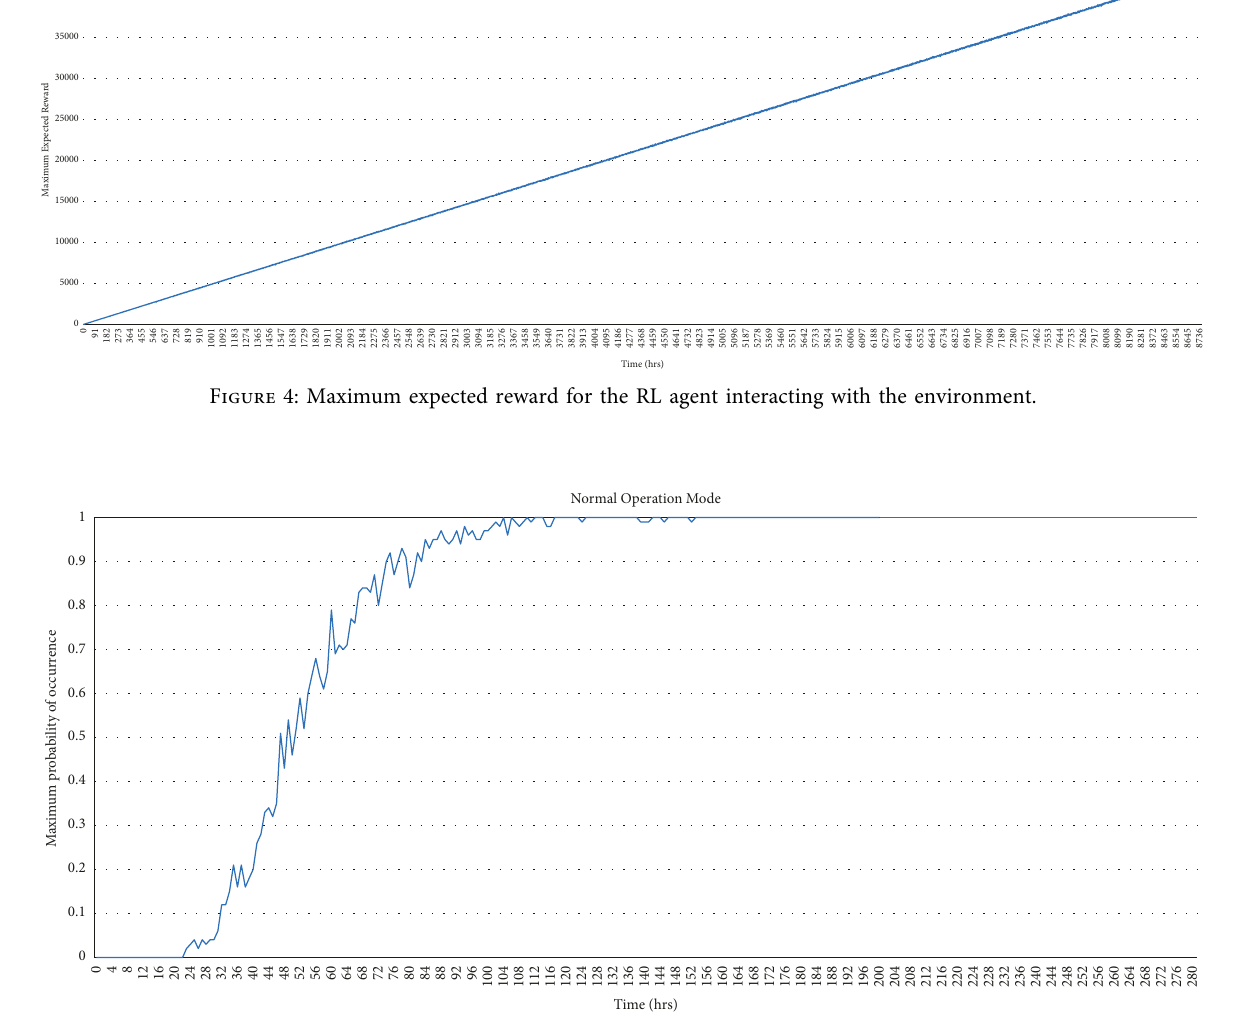
Figure 5: Maximum probability of occurrence of the normal operation